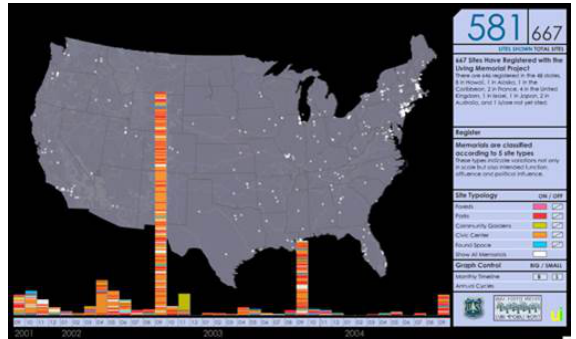
Fig. 2 . Screen capture of Living Memorials from 2001 to 2004, showing locations throughout the U.S., as well as spikes in reported memorials in September of each year. Image courtesy U.S. Forest Service. http://www.livingmemorialsproject.net/